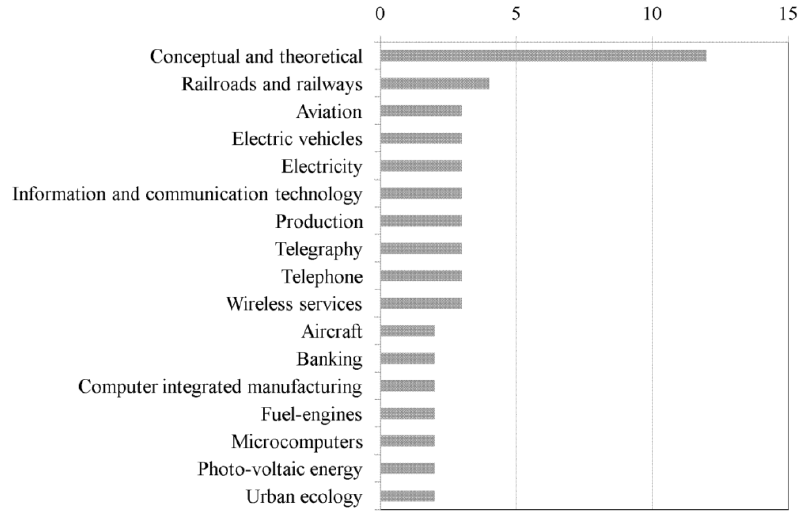
Figure 4. “Most frequently citing research fields (studied technological